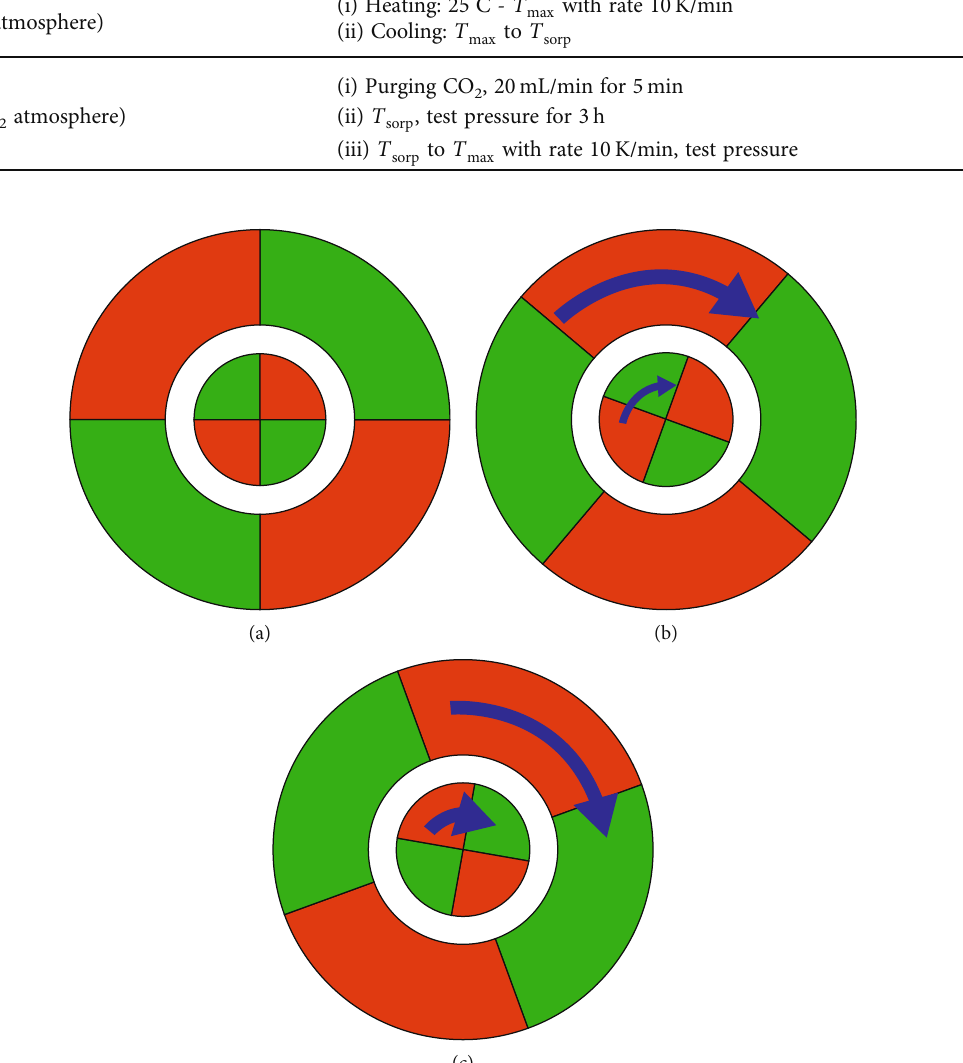
Figure 2: Scheme of the function of the magnetic coupling at deformation with a constant macroscopic shear rate (i.e., a constant angular velocity of the outer magnet). The two colors (orange and green) denote the di ff erent poles of the magnet. (a) Magnetic coupling at rest ( t = 0 ). (b) Initial phase of shearing with continuously increasing angular velocity of the inner magnet ( t > 0 ). (c) Steady-state condition with equal angular velocities of the inner and outer magnet ( t ⟶ ∞ ).